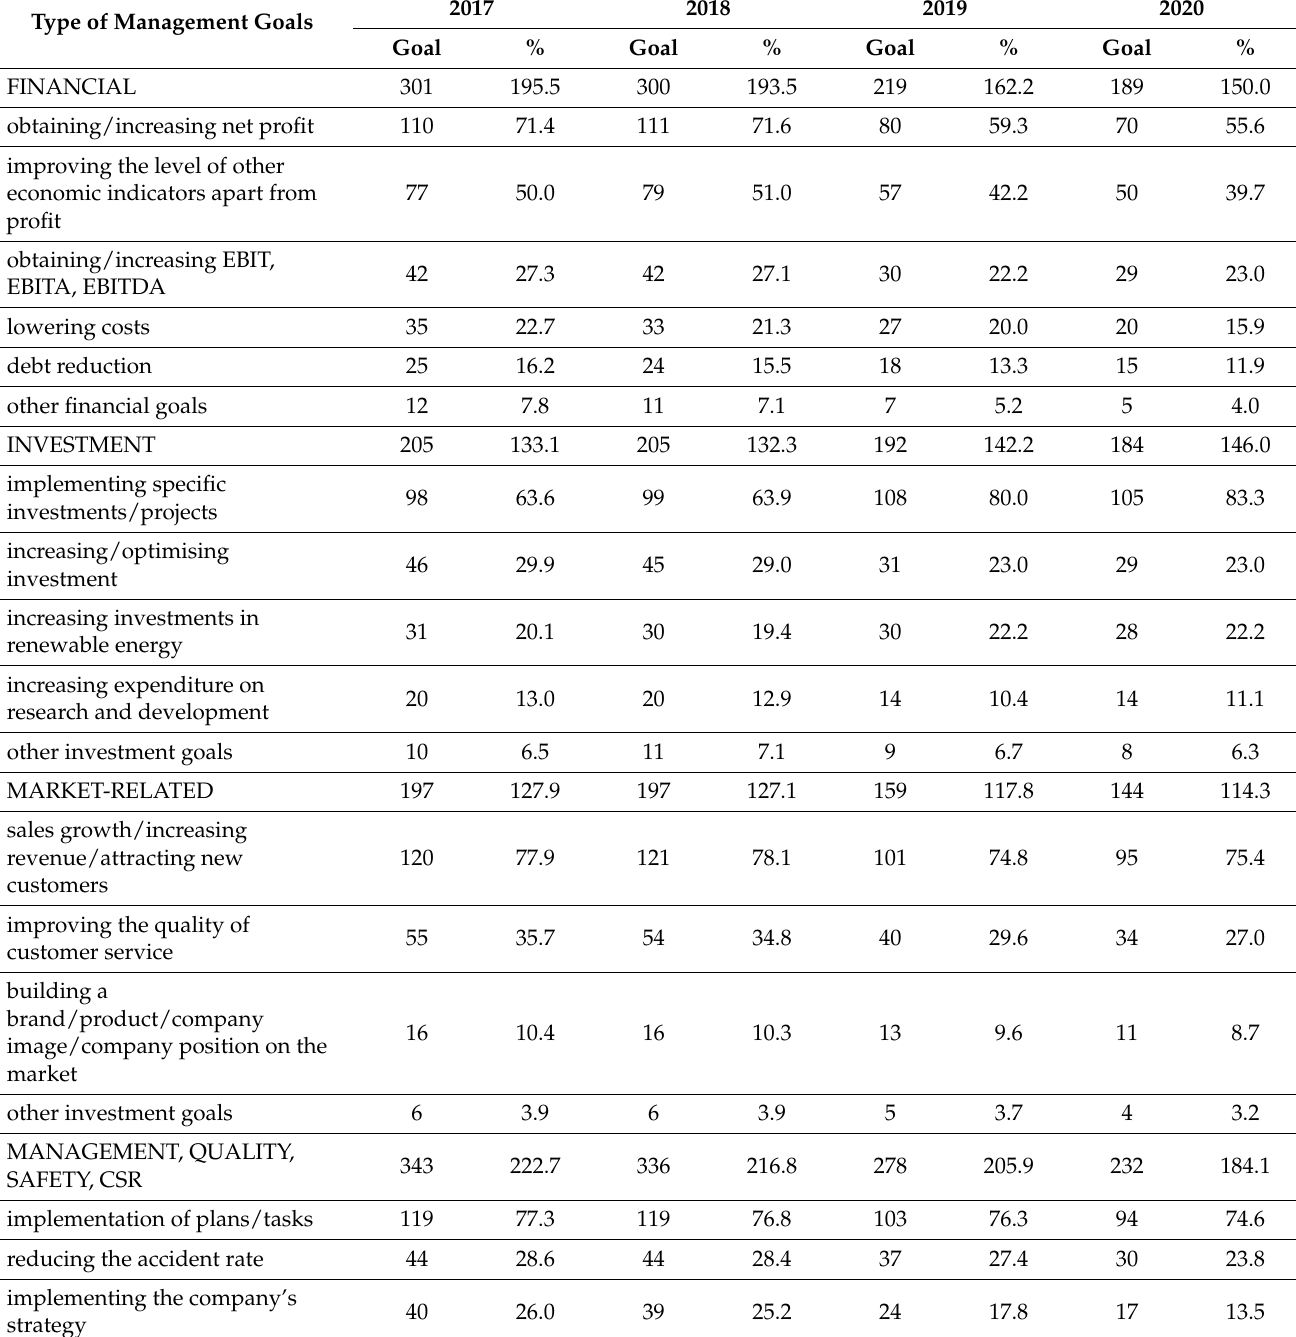
Table 3. List of management goals in Polish energy companies for